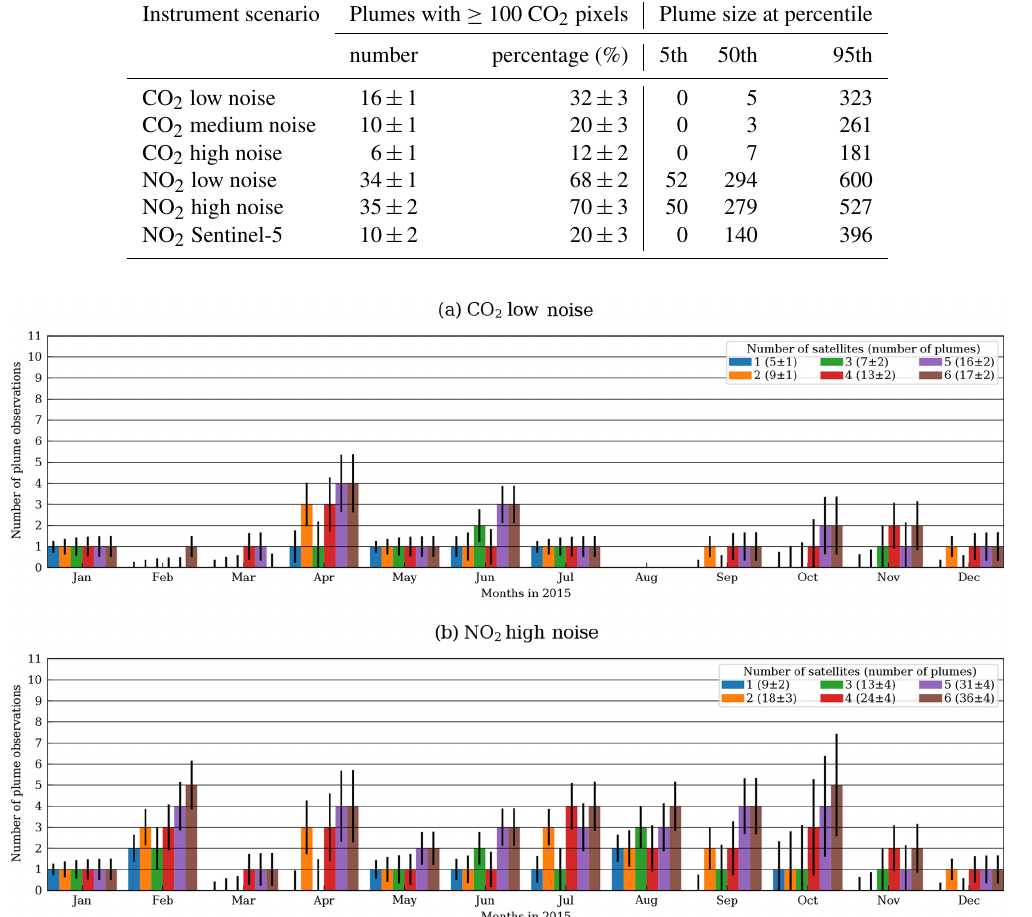
Figure 11. Number of detected plumes with at least 100 pixels (TP ≥ 100 and PPV ≥ 0.80) for one to six satellites with the (a) CO 2 low-noise and (b) NO 2 high-noise scenario. Error bars were estimated from all available satellites with different Equator starting